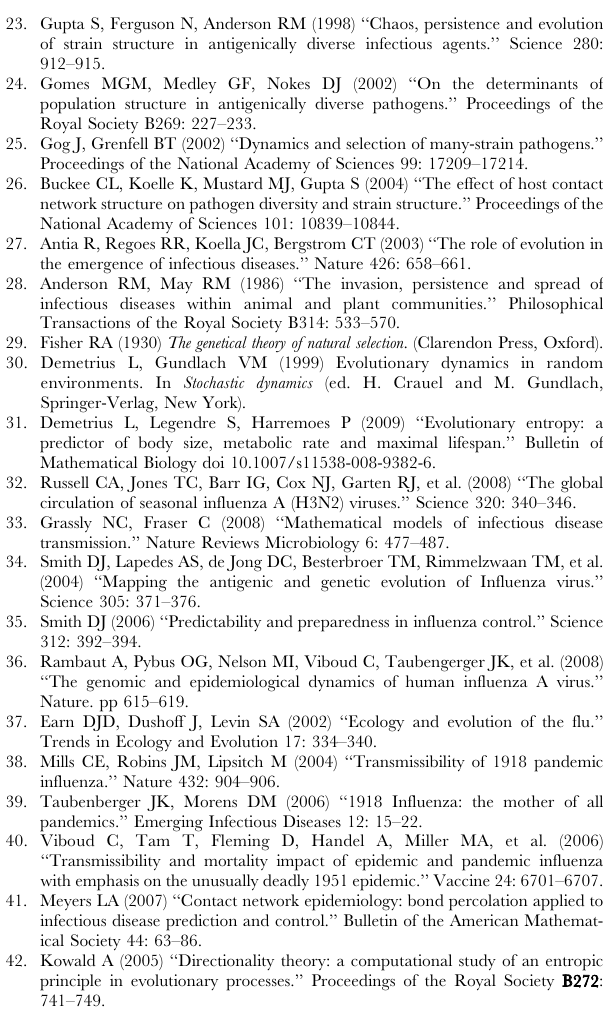
Figure S1 Life cycle for an infective corresponding to the matrix in equation S1 with 4 infectious age